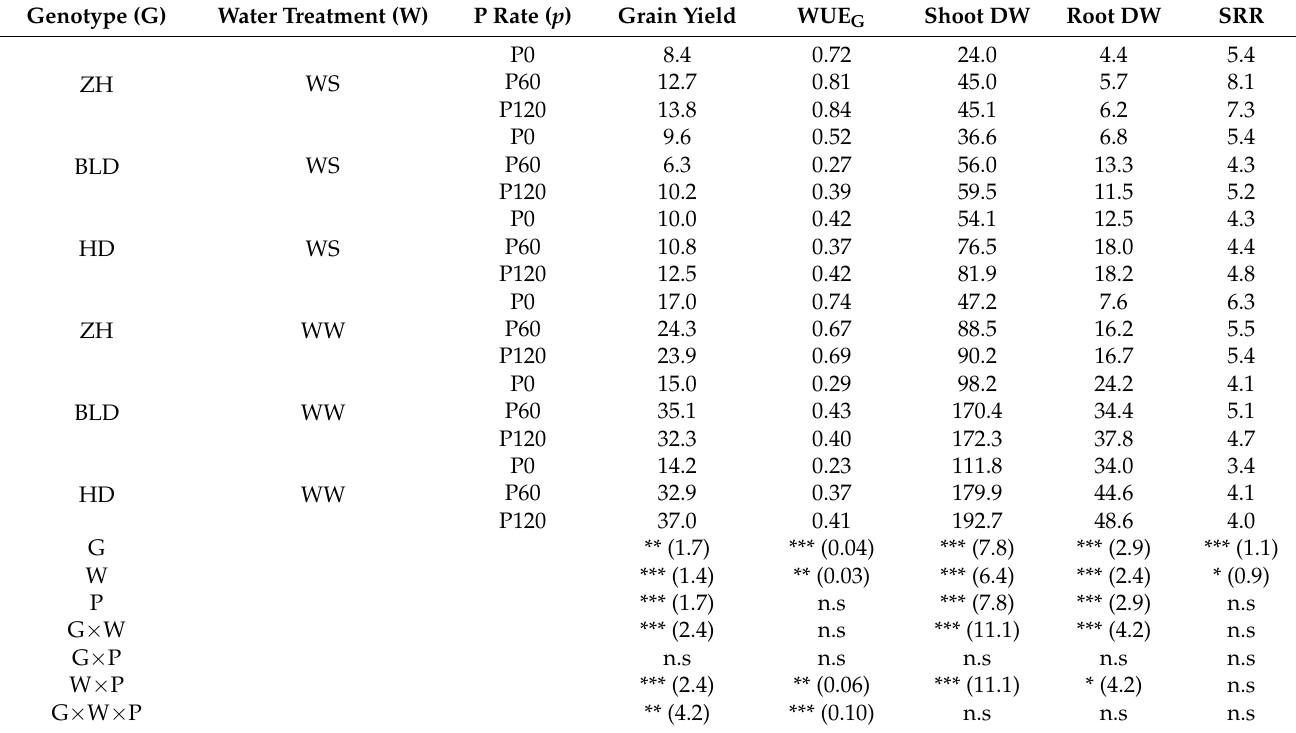
Table 1. The grain yield (g plant − 1 ), water use efficiency for grain yield (WUEG; g kg − 1 ), shoot dry weight (DW, g plant − 1 ), root DW (g plant − 1 ), and shoot to root ratio (SRR, g g − 1 ) at maturity of three soybean genotypes (Huandsedadou (HD), Bailudou (BLD), and Zhonghuang 30 (ZH)) exposed to three P concentrations (0 (P0), 60 (P60) and 120 (P120) mg P kg − 1 dry soil) under water-stressed (WS) and well-watered (WW) conditions. n.s. not significant, * p < 0.05, ** p < 0.01, and *** p < 0.001. Values are means ( n = 3). The values in parenthesis are LSD at p = 0.05. Genotype